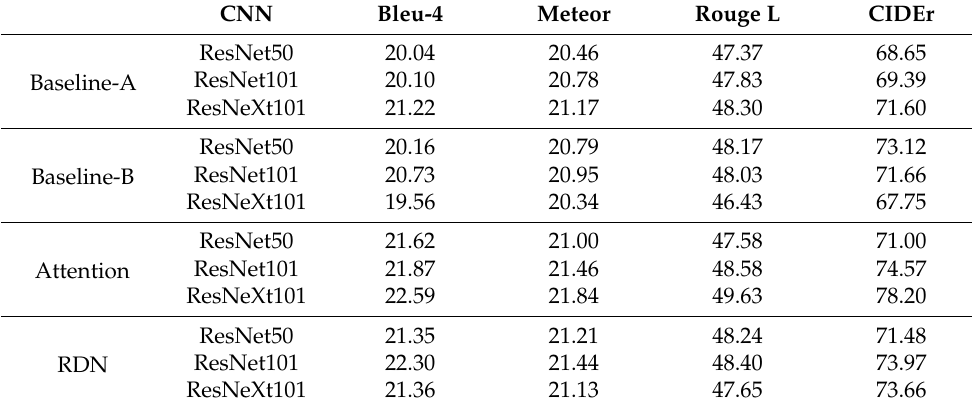
Table 6. Performance on original images.